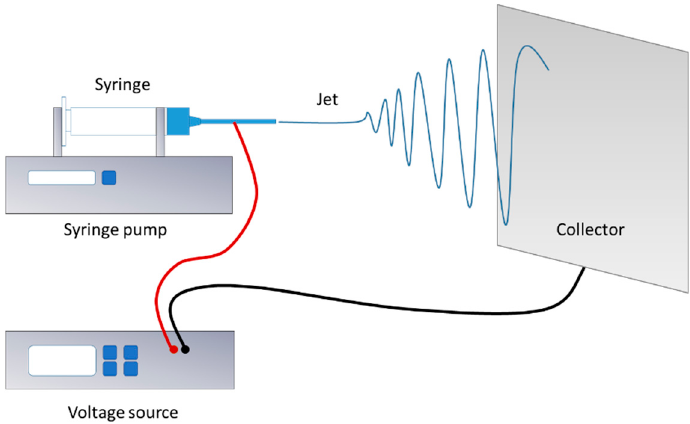
Figure 1. Schematic of an electrospinning setup.